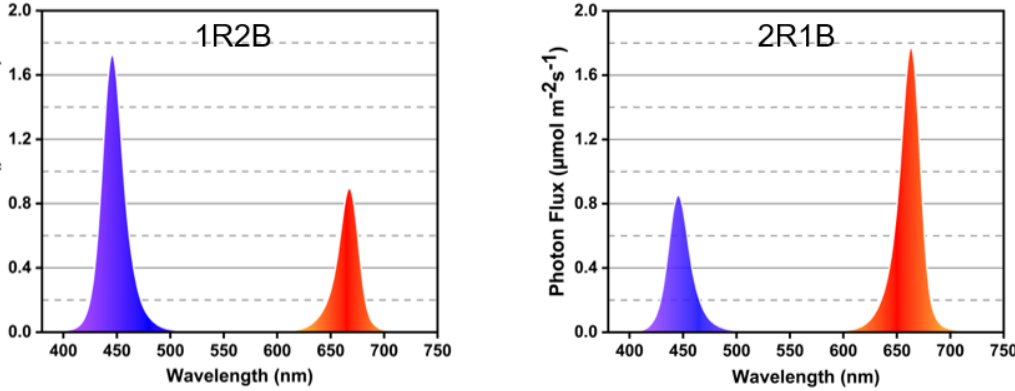
Figure 1. Photon flux density in the ten treatments. The spectral distribution was measured by a spectrometer (ALP − 01, Asensetek, Taiwan).